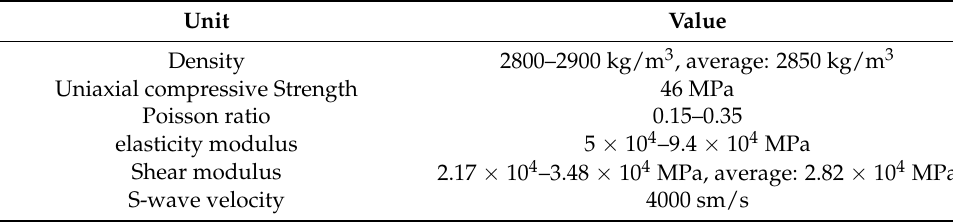
Table 7. Physical and mechanical parameters of dolomite.